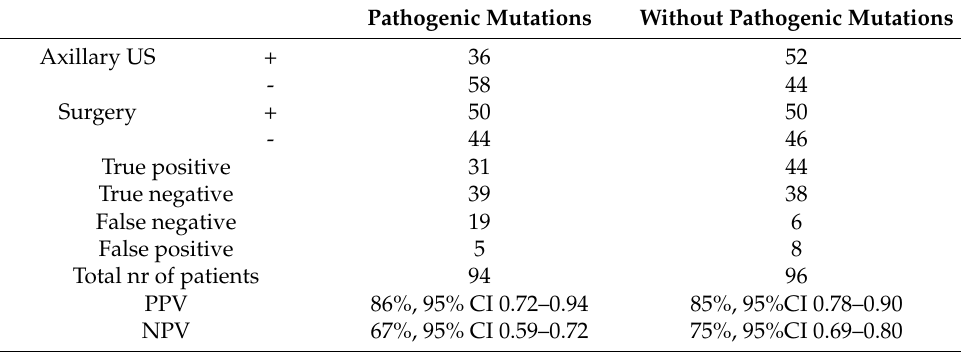
Table 2. Nodal status and pathology findings in study